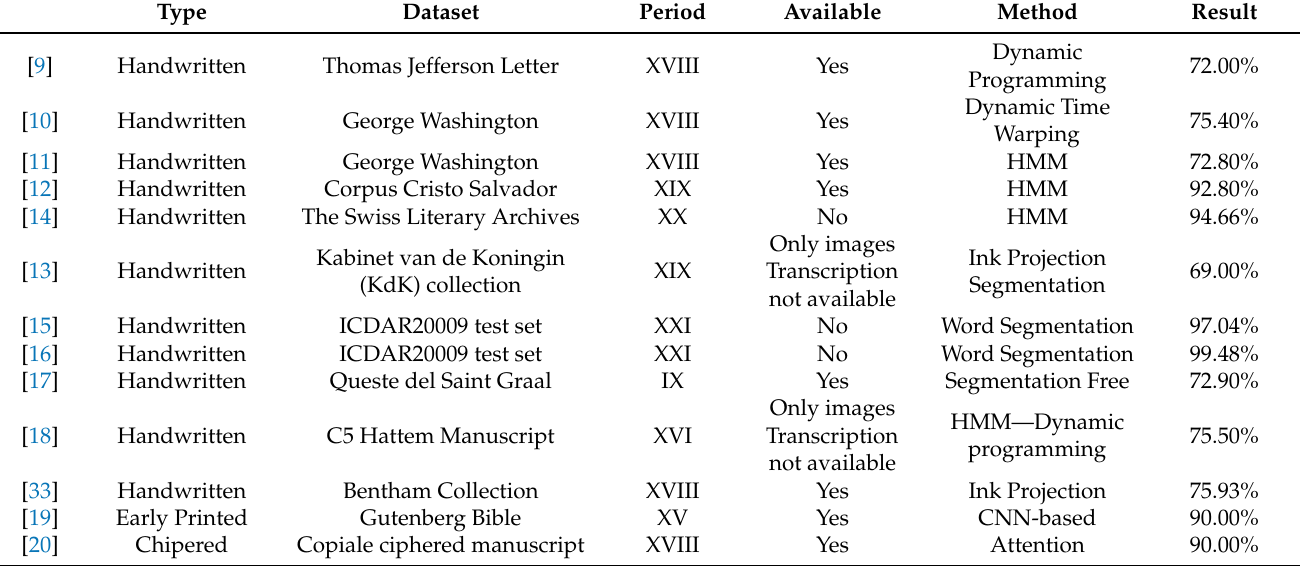
Table 3. Overview of alignment methods in the literature. The period of production is expressed by the ordinal of the century AC. Results are reported in terms of accuracy.